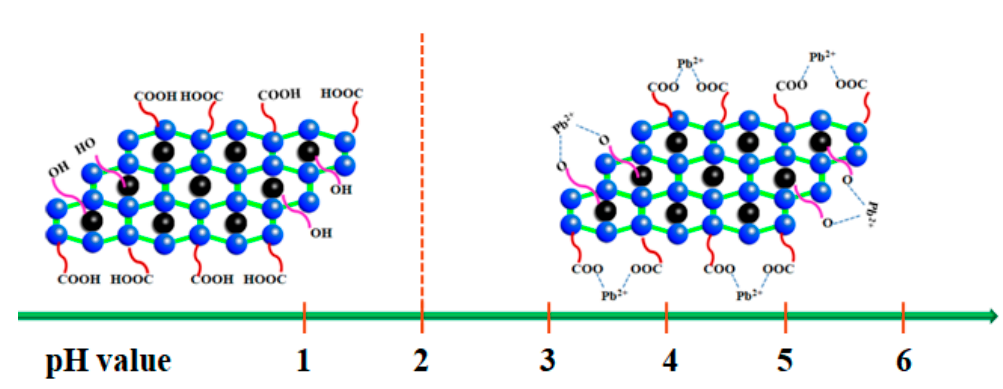
Figure 8. Diagram of the adsorption mechanism.